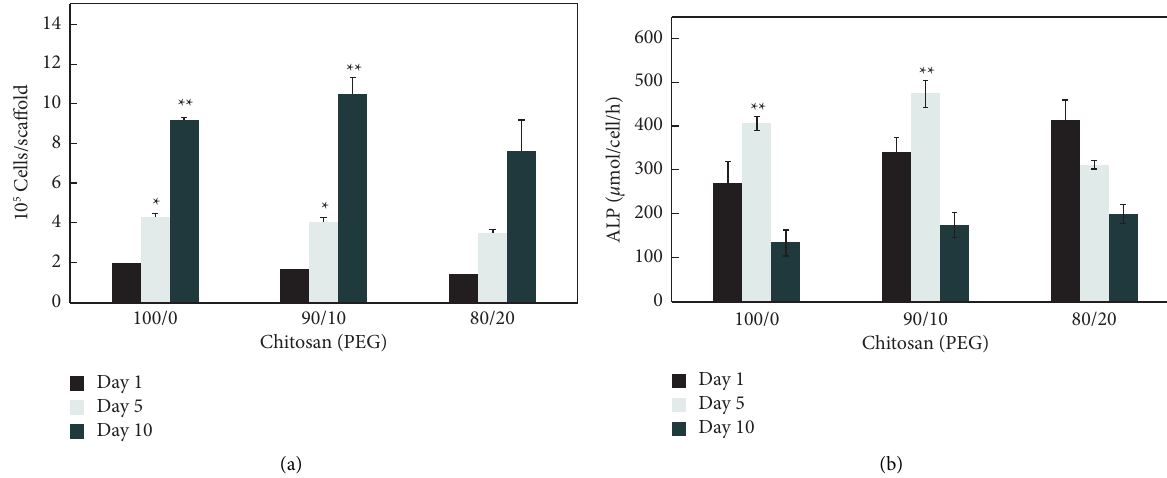
Figure 4: (a) Cell number of osteoblast after 1, 5, and 10 days of seeding on CHI-100, CHI-90, and CHI-80 scafolds. Te values represent mean ± standard deviation, n � 4. ∗ indicates p < 0.05; ∗∗ indicated p < 0.001 vs. Day 1 and Day 5. (b) ALP activity of osteoblast after 1, 5, and 10days of seeding on CHI-100, CHI-90, and CHI-80 scafolds. Te values represent mean ± standard deviation, n � 4. ∗ indicates p < 0.05; ∗∗ indicated p < 0.001 vs. Day 1 and Day